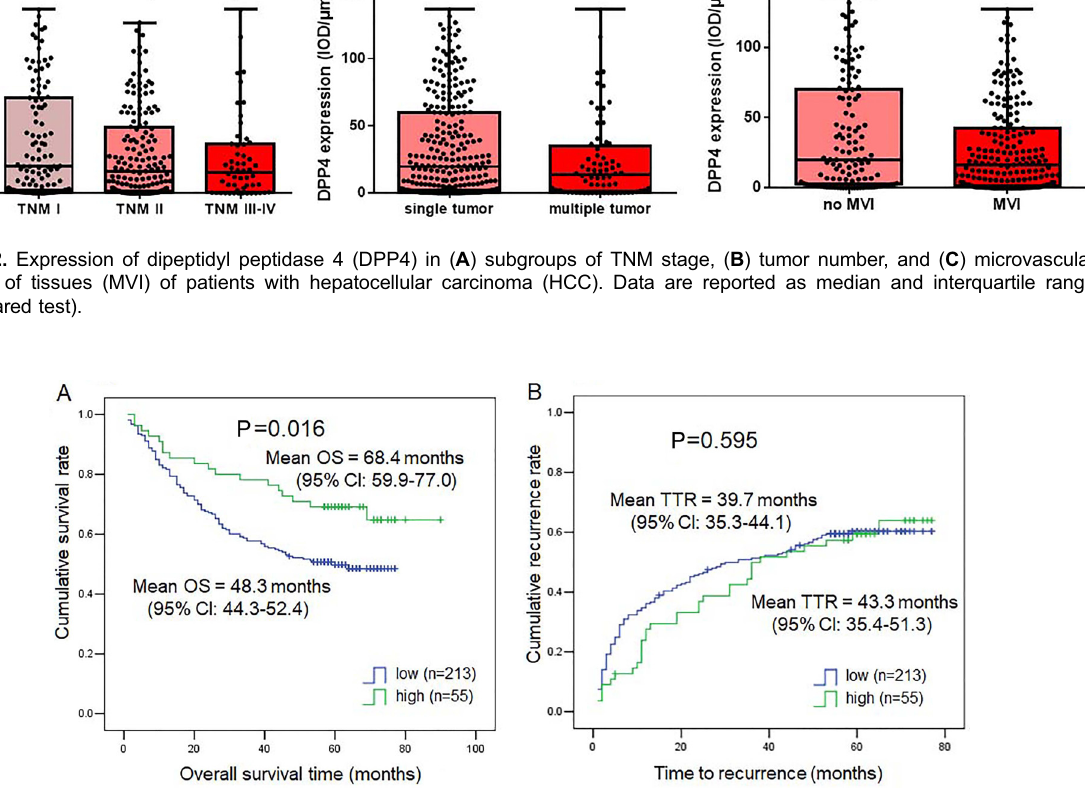
Figure 3. Kaplan-Meier curves for ( A ) overall survival (OS) and ( B ) time to recurrence (TTR) in patients with hepatocellular carcinoma (HCC) (268 cases) expressing low or high levels of dipeptidyl peptidase 4